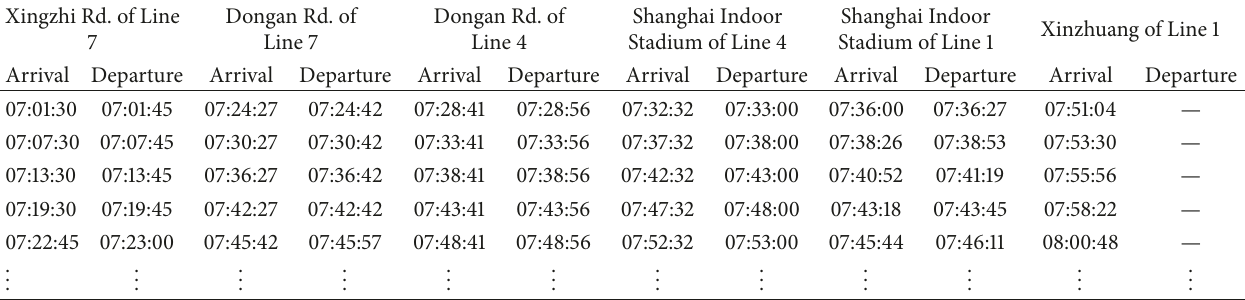
Table 5: The real timetable of trains on Route